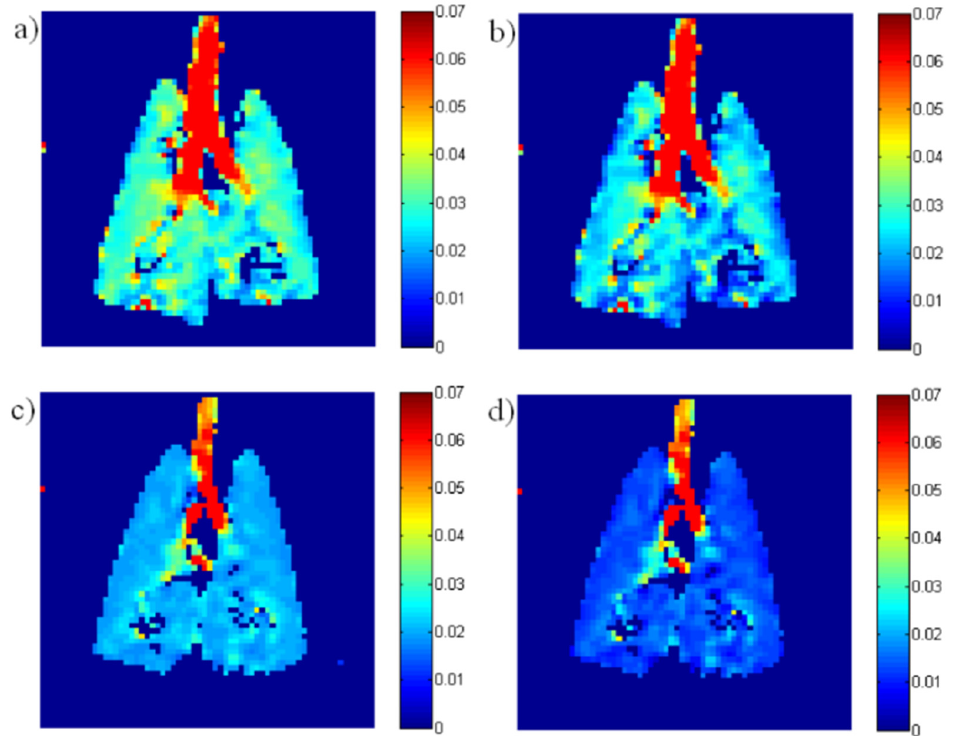
Figure 12. A rat model of radiation-induced lung injury displays a modestly reduced diffusion co- efficient along the terminal airway (DL, ( b )) and a more substantial reduction across the terminal airway/alveolar structure (DT, ( d )) in comparison to the control animal (( a ) and ( c ), respectively). Note that both values approach that of free diffusion in the large airways, as expected.